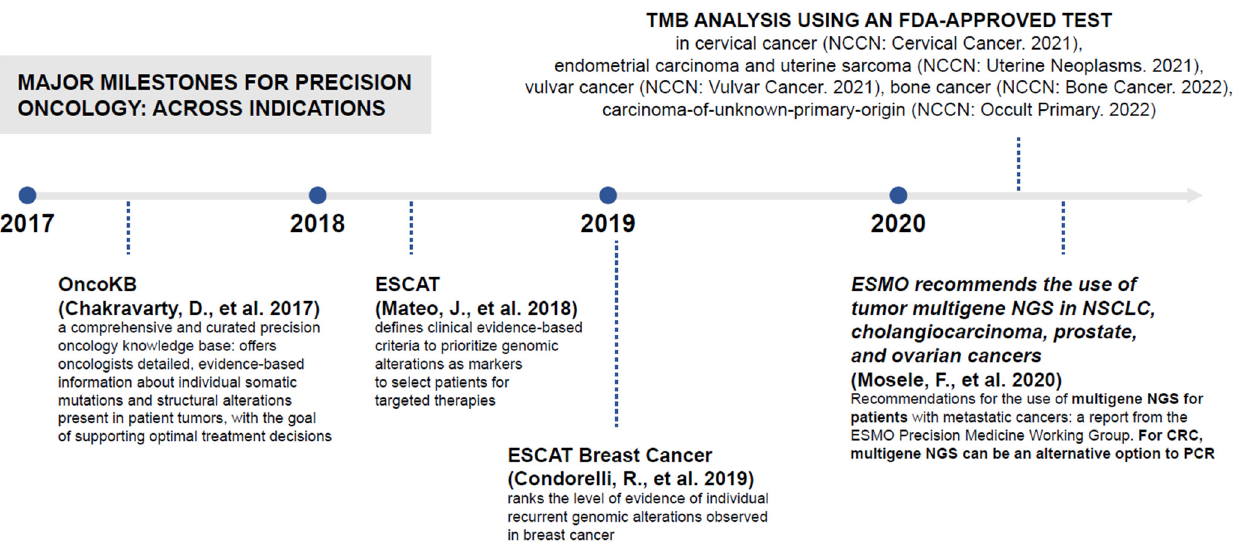
Figure 1. Evolution of support for genomic testing within guidelines. CRC, colorectal cancer; ESCAT, ESMO Scale for Clinical Actionability of molecular Targets; ESMO, European Society for Medical Oncology; FDA, Food and Drug Administration; NGS, next-generation sequencing; NSCLC, non-small cell lung cancer; PCR, polymerase chain reaction; TMB, tumor mutational burden.